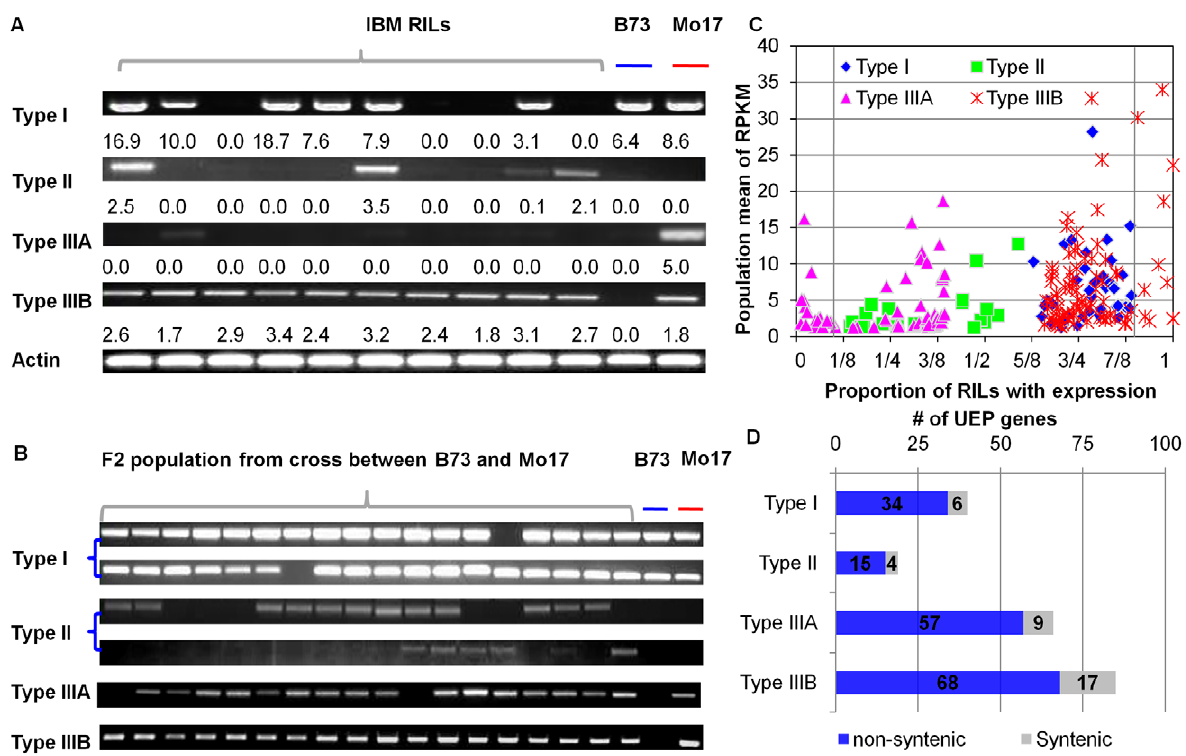
Figure 5. Four types of unexpected expression patterns between the RILs and their parents. Type I: genes expressed in both B73 and Mo17, but not expressed in at least 1/10 of the RIL population. Type II: genes not expressed in both B73 and Mo17, but expressed in at least 1/10 of the RIL population. Type III: genes expressed in either B73 or Mo17, have abnormal segregation ratio of expression versus non-expression in RILs, such as 1:3, 3:1 etc. Type IIIA are genes tending to be expressed in fewer RILs than the expected 1:1 ratio while Type IIIB are genes that tend to be expressed in more RILs than the expected 1:1 ratio. In (A), gene transcripts in the Type I , III categories were amplified by RT-PCR from RNAs isolated from an independent replication of 10 genotypes from the IBM population. Thirty-five cycles of PCR was conducted for genes GRMZM2G403162 (Type I), GRMZM2G168987 (Type II), GRMZM2G103479 (Type IIIA), GRMZM2G170588 (Type IIIB) and a housekeeping gene ( Actin ). The number under each band shows the RPKM value in each RIL. (B) RT-PCR assay of individuals in an F 2 population from the cross between B73 and Mo17. The corresponding genes from top to bottom are GRMZM2G403162 , GRMZM2G053790 , GRMZM2G168987 , GRMZM2G071808 , GRMZM2G103479 , and GRMZM2G170588 . (C) The percent of RILs with expressed genes with unexpected expression patterns and population mean of their expression levels in the RILs. The x-axis represents the percent of RILs, while the y-axis indicates the log2 score of the population mean of RPKM. The two grey vertical lines mark 10% and 90% of the RILs. (D) The number of genes for each of these unexpected expression patterns and the proportion of syntenic and non-syntenic genes in each expression pattern.